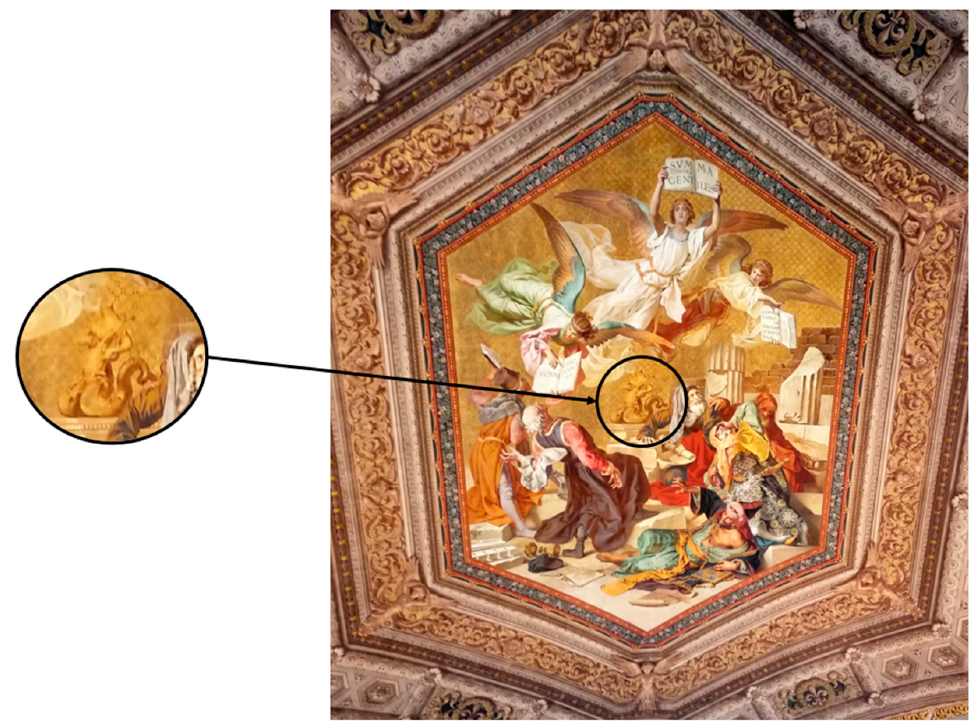
Figure 13. Angels holding the Summa contra Gentiles by St. Thomas Aquinas, Vault Fresco Gallery of Maps, Vatican, 1580s.